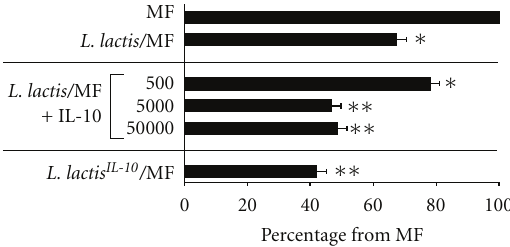
Figure 5: Immature DC primed with MF/ L. lactis and increasing amounts of recombinant human IL-10 (0, 0.5, 5 and 50 ng/mL). Bar graphs represent the mean inhibition of fluorescence intensity of allogenic Th-cells for the indicated conditions in duplo. The proliferation of allogenic Th-cells cocultured with e ff ector Th- cells derived from MF-matured DC is regarded as 100% (reference condition). Mean percentages with standard error of mean are given; ∗ indicates P < 0 . 05 and ∗∗ indicates P < 0 . 01 using the χ 2 - test for comparing percentages with the reference condition